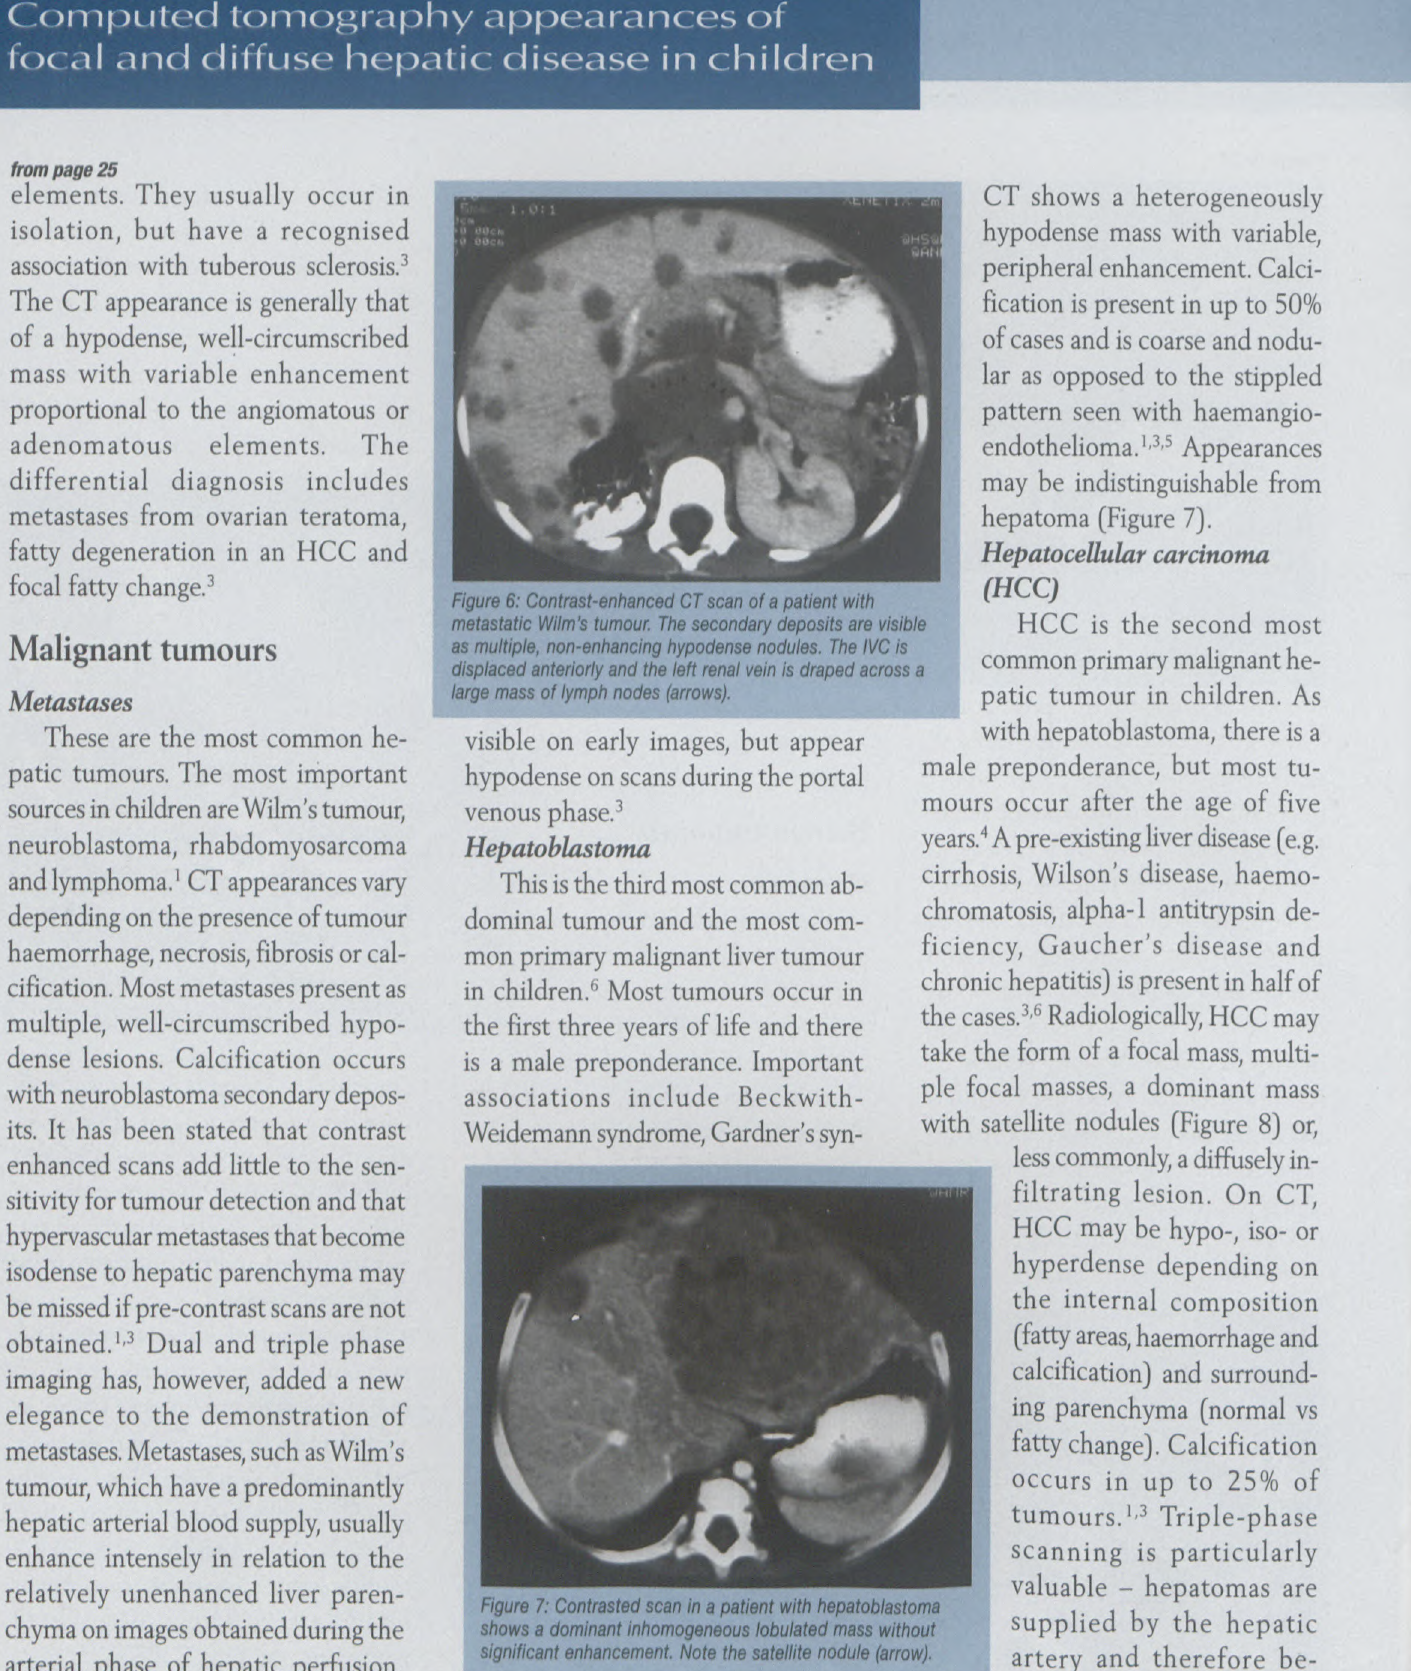
Figure 7: Contrasted scan in a patient with hepatoblastoma shows a dominant inhomogeneous lobu/ated mass without significant enhancement. Note the satellite nodule